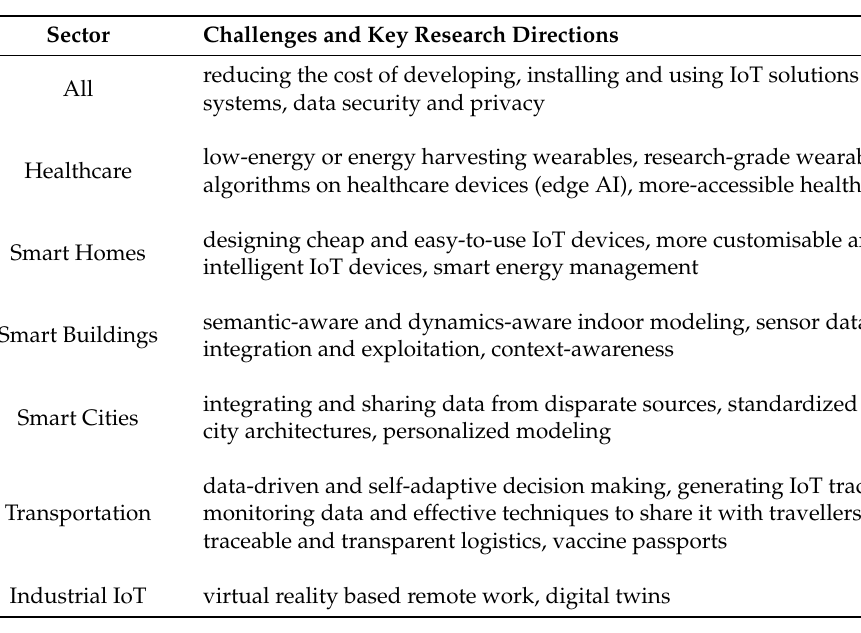
Table 2. A summary of major challenges and key research